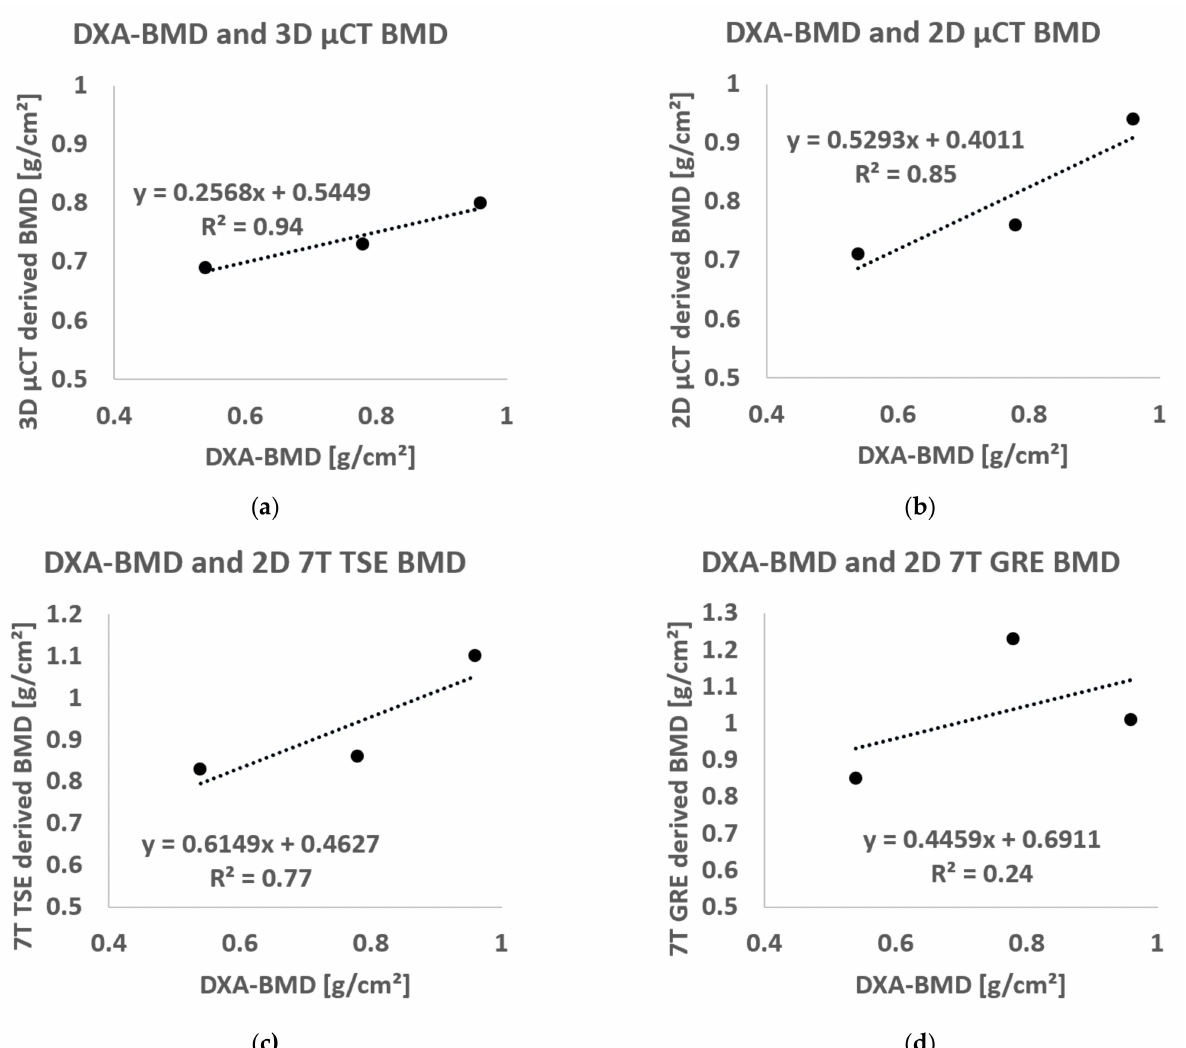
Figure 9. Linear regression between BMD calculated using standard DXA analysis and BMD derived using ( a ) µ CT 3D approach, ( b ) µ CT 2D approach, ( c ) TSE 2D approach and ( d ) GRE 2D